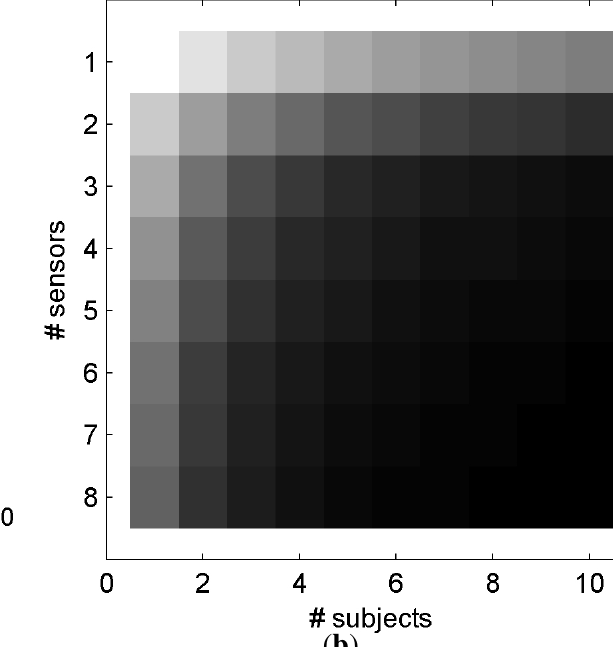
Figure 8. AUC based on the number of electrodes and subjects with the SS for electrode selection and O for fusing the classifier outputs across subjects. ( a ) 3D sum representation of the AUC; ( b ) 2D representation of the AUC. (In Figure ?? b, a dark gray level represents a high